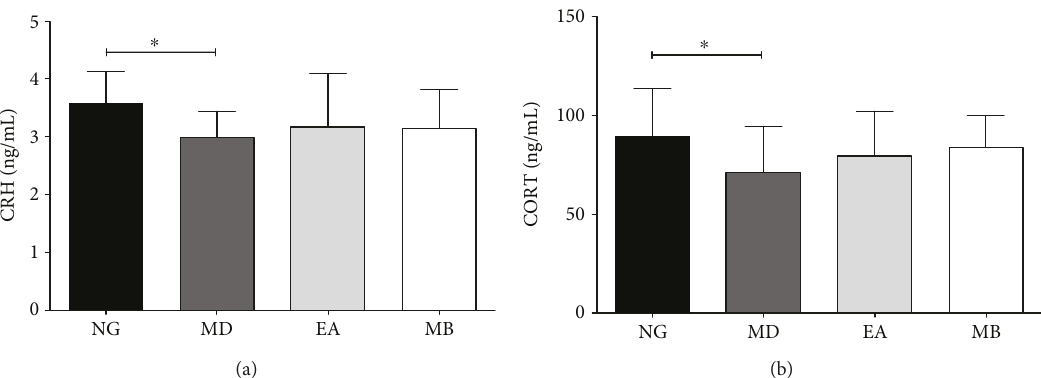
Figure 5: The CRH and CORT concentration in serum. The results showed that the concentration of CRH and CORT in the MD group signi fi cantly decreased ( P < 0 05 vs. NG group). On the contrary, after EA or MB interventions, the concentrations of CRH and CORT were slightly increased. (a) The CRH concentration and (b) the CORT concentration. CRH: corticotropin-releasing hormone; CORT: cortisol.